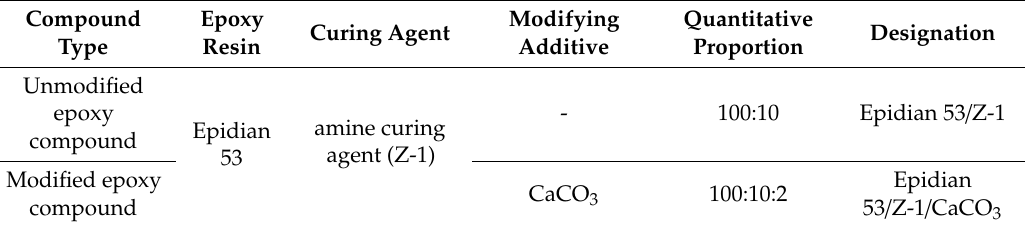
Table 1. The quantitative proportion of the epoxy compounds.